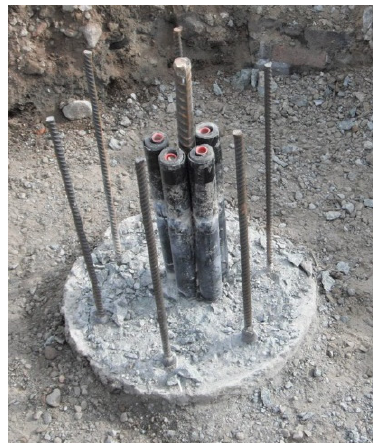
Figure 1. Example of a pile heat exchanger following pile trimming and prior to connection to the building base slab and the ground-source heat pump system. In this particular case the heat transfer pipes are centrally located and still retain their protective sleeves, which were used to avoid their damage during trimming.